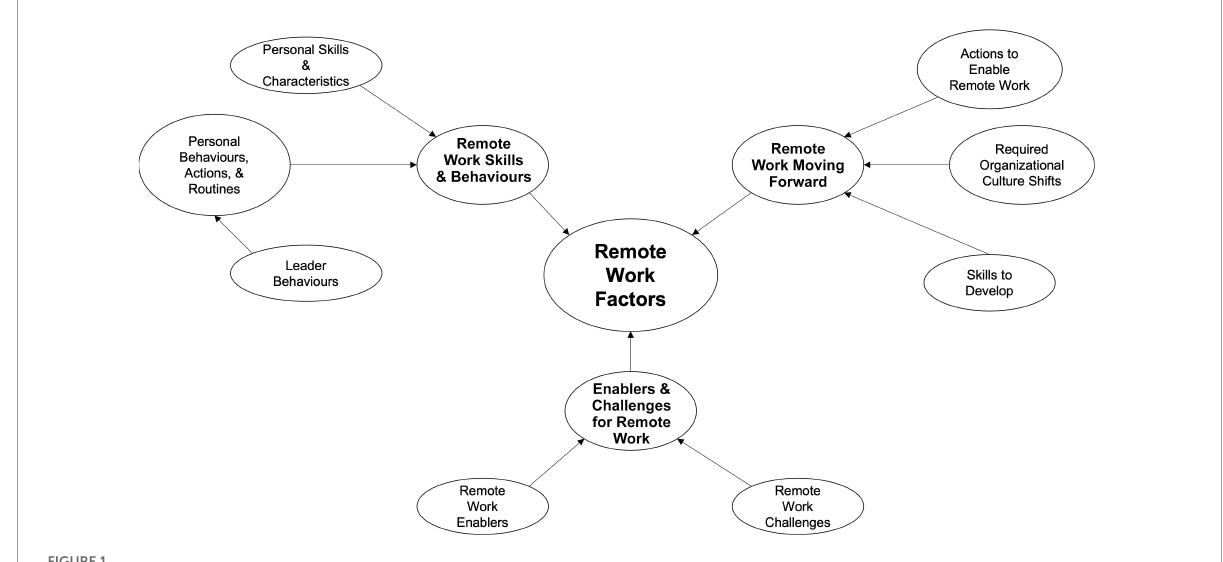
FIGURE1 Thematic map of meta-themes and